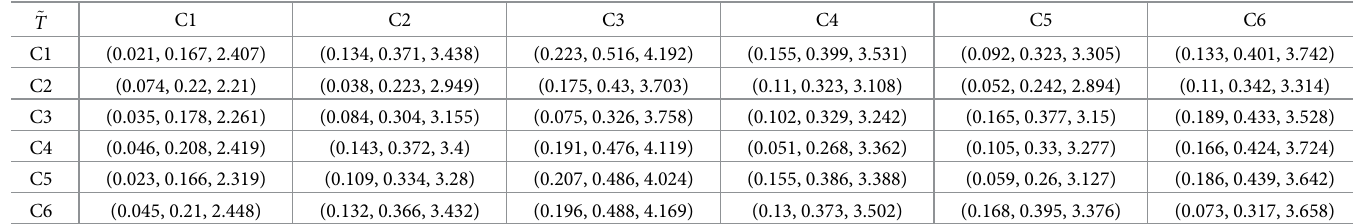
Table 7. Full contact matrix of the main criteria.